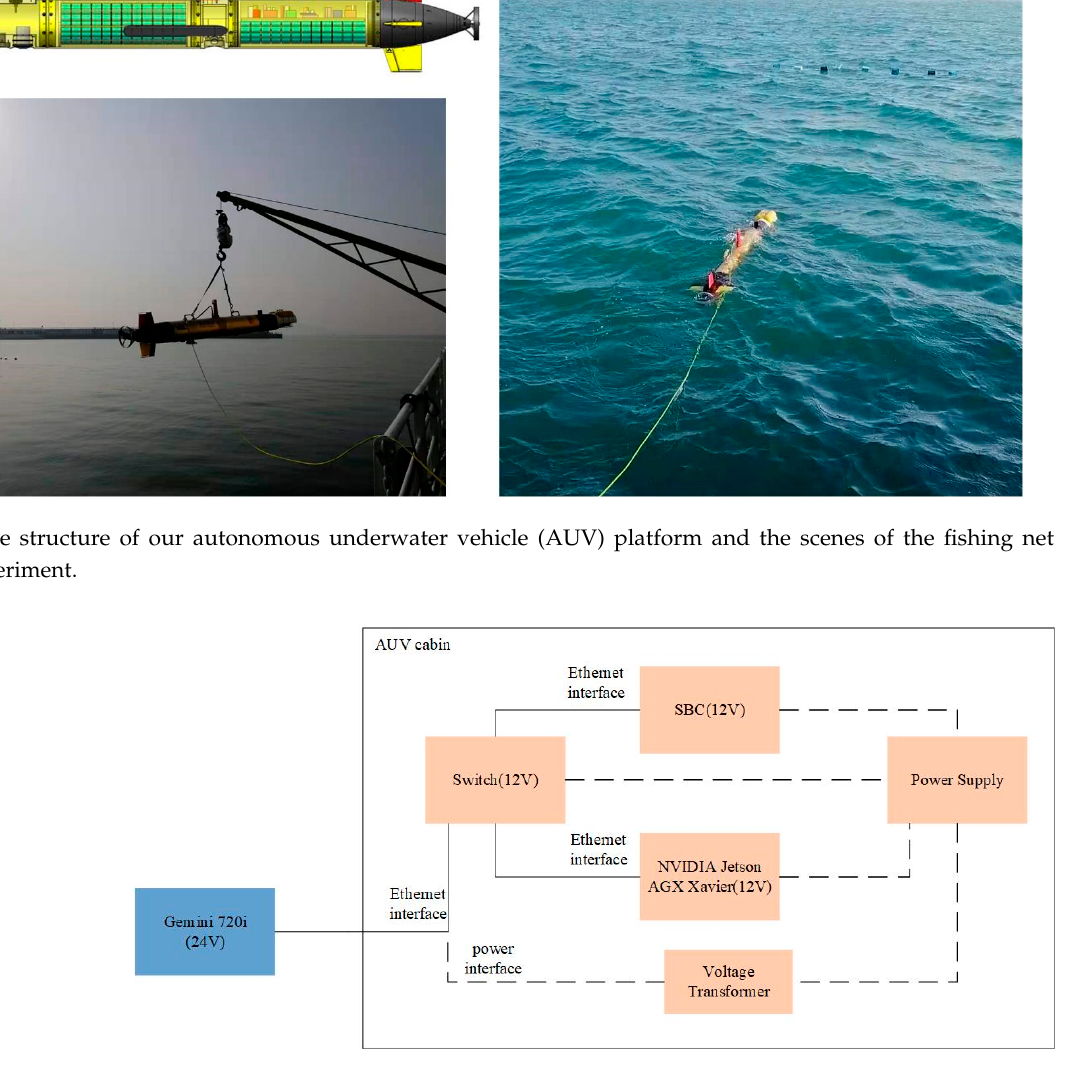
Figure 16. The process of the real-time detection experiment. Note: t1 is the time of interpolation, t2 is the time of transfer- ring a FLS image, and t3 is the inference time of the network. We compared the saved real-time detection results with the ground-truth of offline manual annotation. The results are shown in Figure 17. We collected 5184 FLS images as a testing set in the experiment to measure the generalization ability of MRF-Net. In terms of mAP, our results show that MRFNet can achieve a mAP of 87.3%, which is comparable to the performance in Table 3.